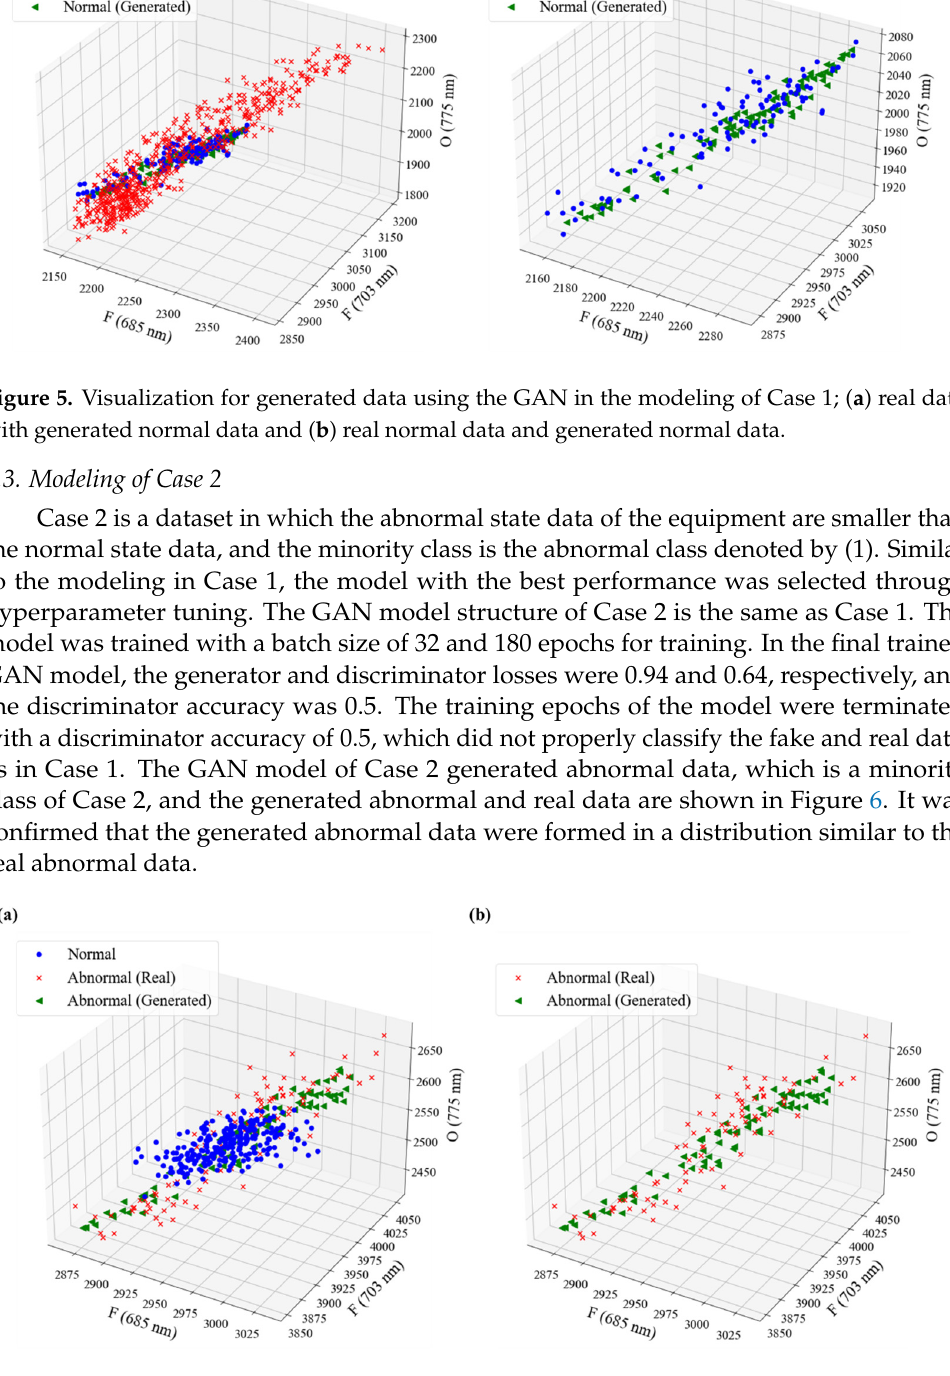
Figure 6. Visualization for the generated data using the GAN in modeling of Case 2; ( a ) real data with generated abnormal data and ( b ) real abnormal data and generated abnormal